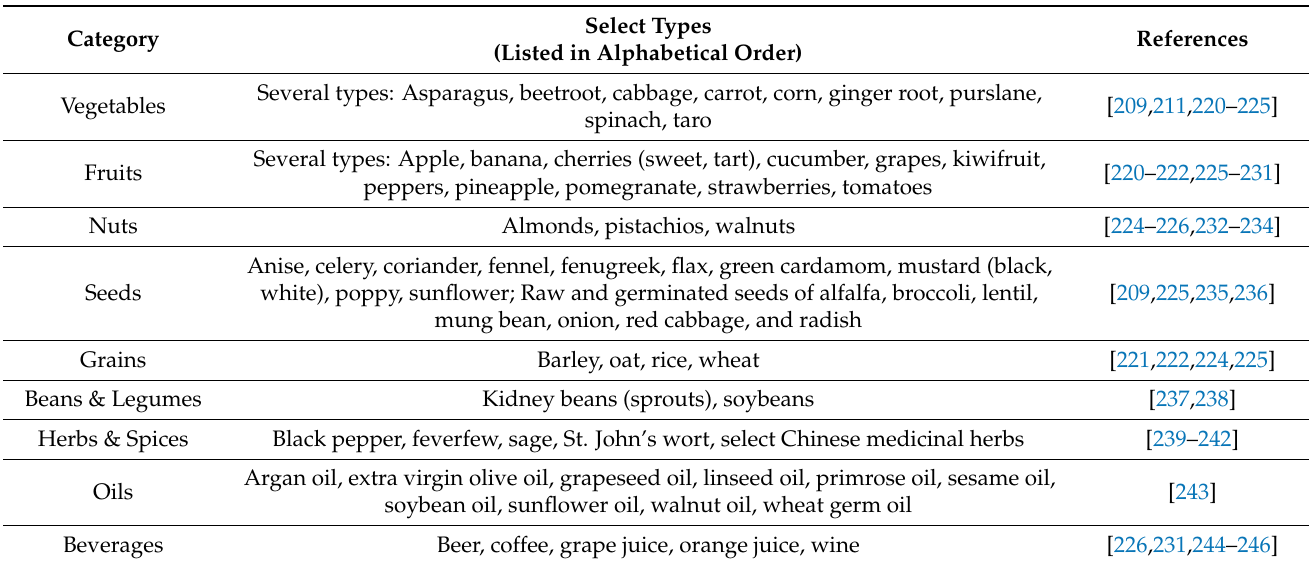
Table 3. Select plant food sources of